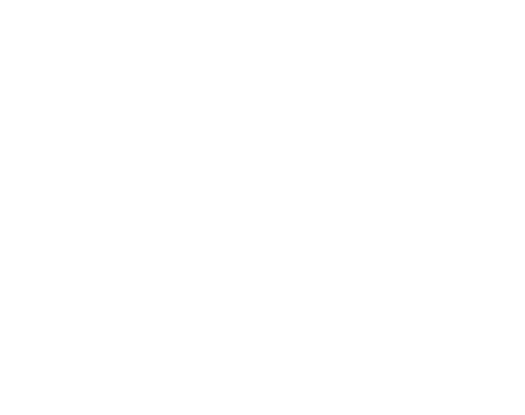
Table 1. Error measures for the proposed